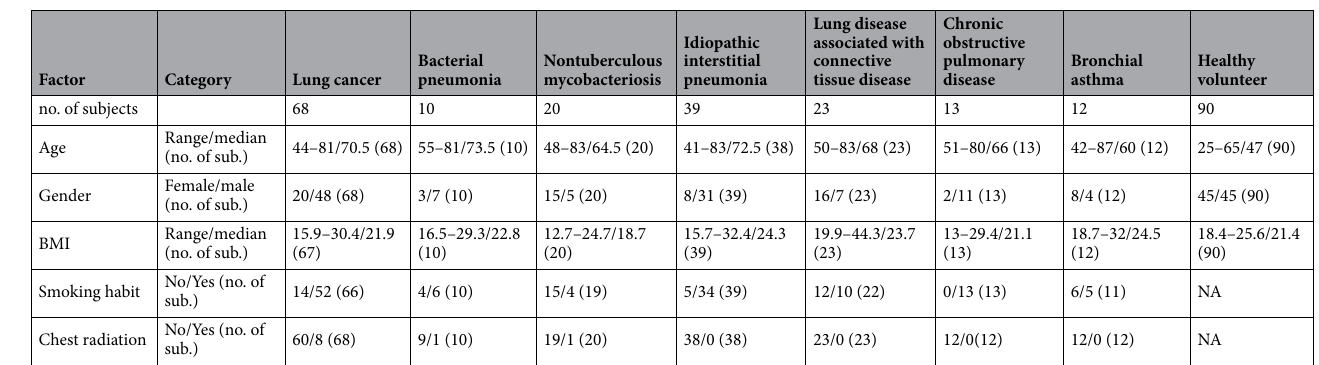
Table 2. Summary of background information of patients with other lung diseases and healthy volunteers used for LPC biomarker